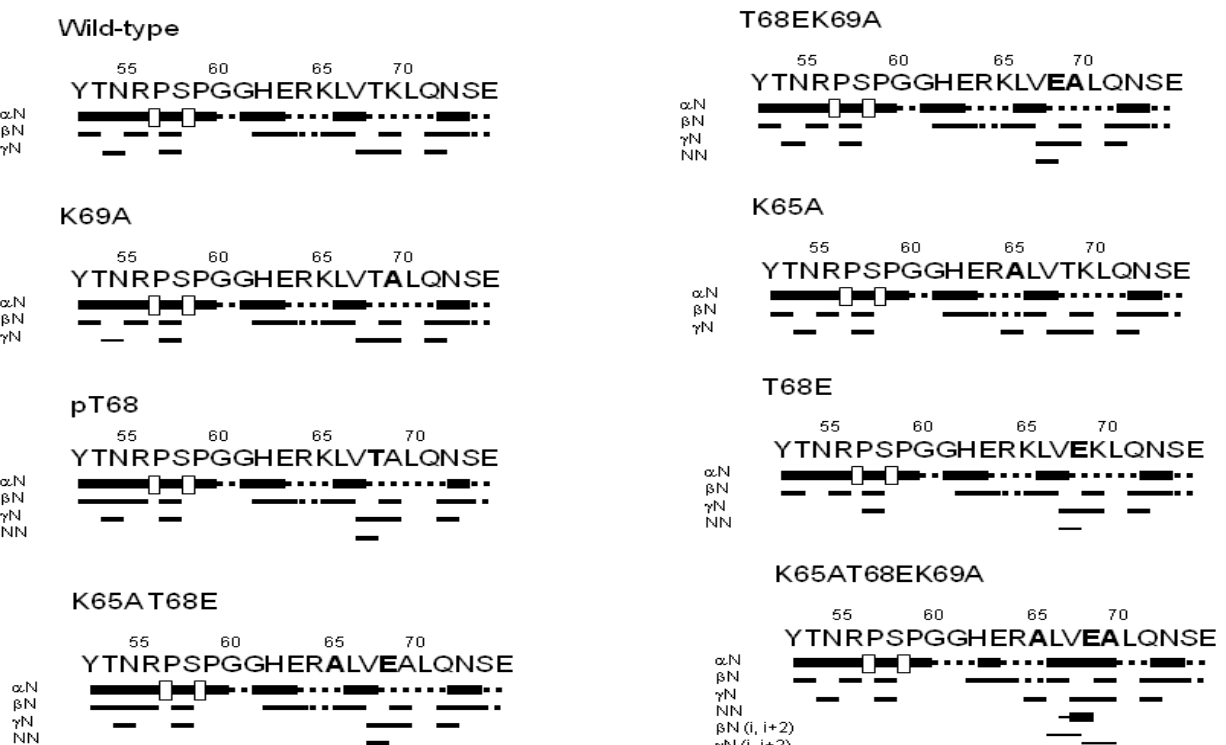
Figure 1. NMR structural characterization of the nuclear localization sequence (NLS) NUPR1 peptides. Nuclear Overhauser e ff ects (NOEs) are classified into strong, medium, or weak, as represented by the height of the bar underneath the sequence; the signal intensity was judged by visual inspection from the nuclear Overhauser e ff ect spectroscopy (NOESY) experiments. The symbols α N, β N, γ N, and NN correspond to the sequential contacts (that is, for instance, the NN corresponds to the NN ( i , i + 1) contacts). The corresponding H α NOEs with the H δ of the following proline residues are indicated by an open bar in the row corresponding to the α N contacts. The dotted lines indicate NOE contacts that could not be unambiguously assigned due to signal overlap. The numbering of the residues corresponds to that of the whole sequence of NUPR1.